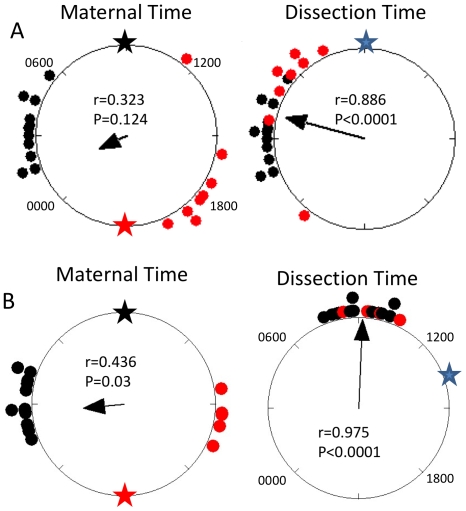
Circular phase plots of embryonic liver rhythms in vitro from two experiments showing that in vitro phase is set by the explantation procedure.Livers were collected from Per2::luc mice and the relative levels of PER2 protein were measured by the recorded light emissions. Phases of in vitro rhythms were determined as described in Methods. The large circles represent the second 24 hours in culture and each small circle represents the phase of peak luminescence of an individual sample. In both experiments the same data are plotted relative to two different references, Maternal Time and Dissection Time. The phases of embryonic liver rhythms were consistently clustered relative to dissection time and not relative to maternal time. A. Livers were collected at two times of day, 12 hours apart, ZT12 (E15.5) and ZT0 (E16). Maternal Time corresponds to clock time since all mothers were entrained to the same light:dark cycle with lights on at 0900 (ZT0) and off at 2100 (ZT12). Red circles represent tissues collected at ZT12 (red star) and black circles represent those collected at ZT0 (black star). For Dissection Time phases are plotted relative to the time of dissection (blue star) regardless of the time of day when dissection was done. B. Two groups of mothers were entrained to different light:dark cycles 12 hours apart (see Fig. S3) and livers were collected at one time of day (1400) and at one embryonic age (E15.25). Because mothers were entrained to different ligh:dark cycles Maternal Time does not correspond to clock time. The red symbols represent embryo samples from mothers with lights off at 1400 and black circles represent those from mothers with lights off at 0200. Because dissections were done at the same time of day for both groups (1400, blue star), Dissection Time corrresponds to clock time. The dissections occurred at different times relative to Maternal Time, ZT0 (black star) or ZT12 (red star). The arrow inside each large circle indicates the average phase of all samples. The arrow's length and the r value indicate the degree of synchrony. P is the probability that the distribution of phases is significantly different from uniform (Rayleigh Test). Each experimental group included samples from at least two pregnant mice.